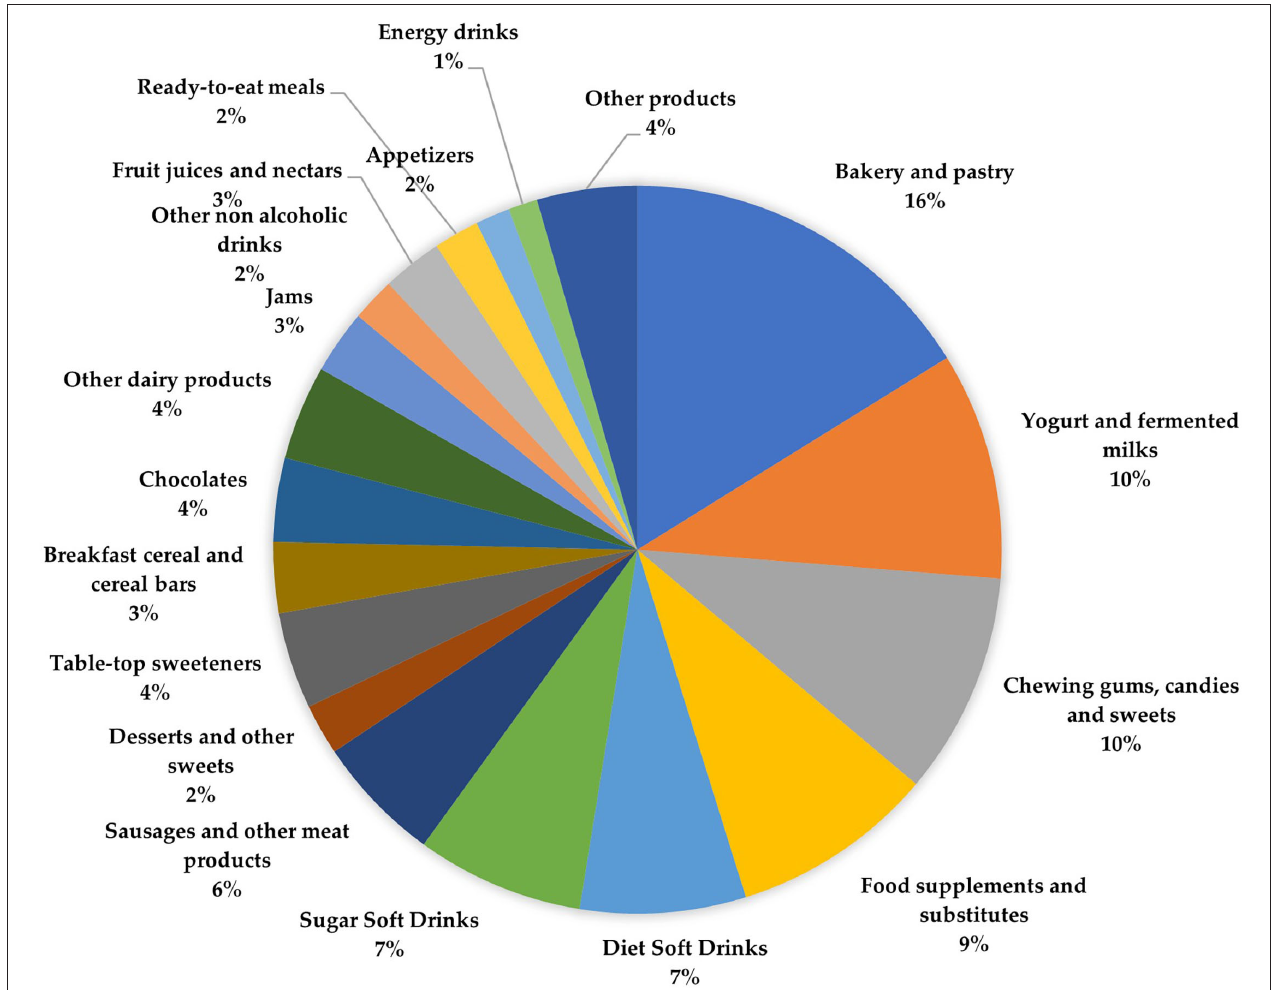
FIGURE 1 | Distribution of food and beverage subgroups (%) available in the Spanish market containing one or more low and no-calorie sweeteners (LCNS) as declared in their ingredient information.